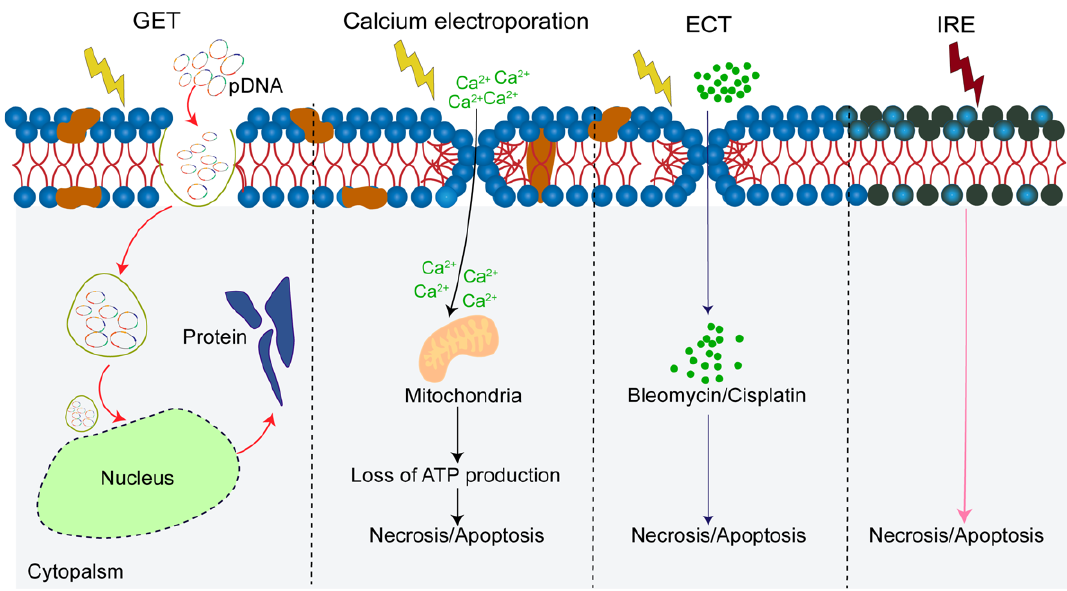
Figure 1. The diagram of cellular mechanisms in electroporation and electroporation-based treat- ments. Calcium ion, chemotherapeutic drugs and genetic fragment are transferred to the cell during the electroporation. pDNA, plasmid DNA; GET, gene electrotransfer; ECT, electrochemotherapy; IRE, irreversible electroporation.